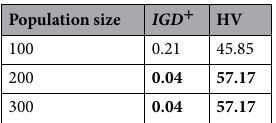
Table 7. Comparison of initial population number. Significant values are in